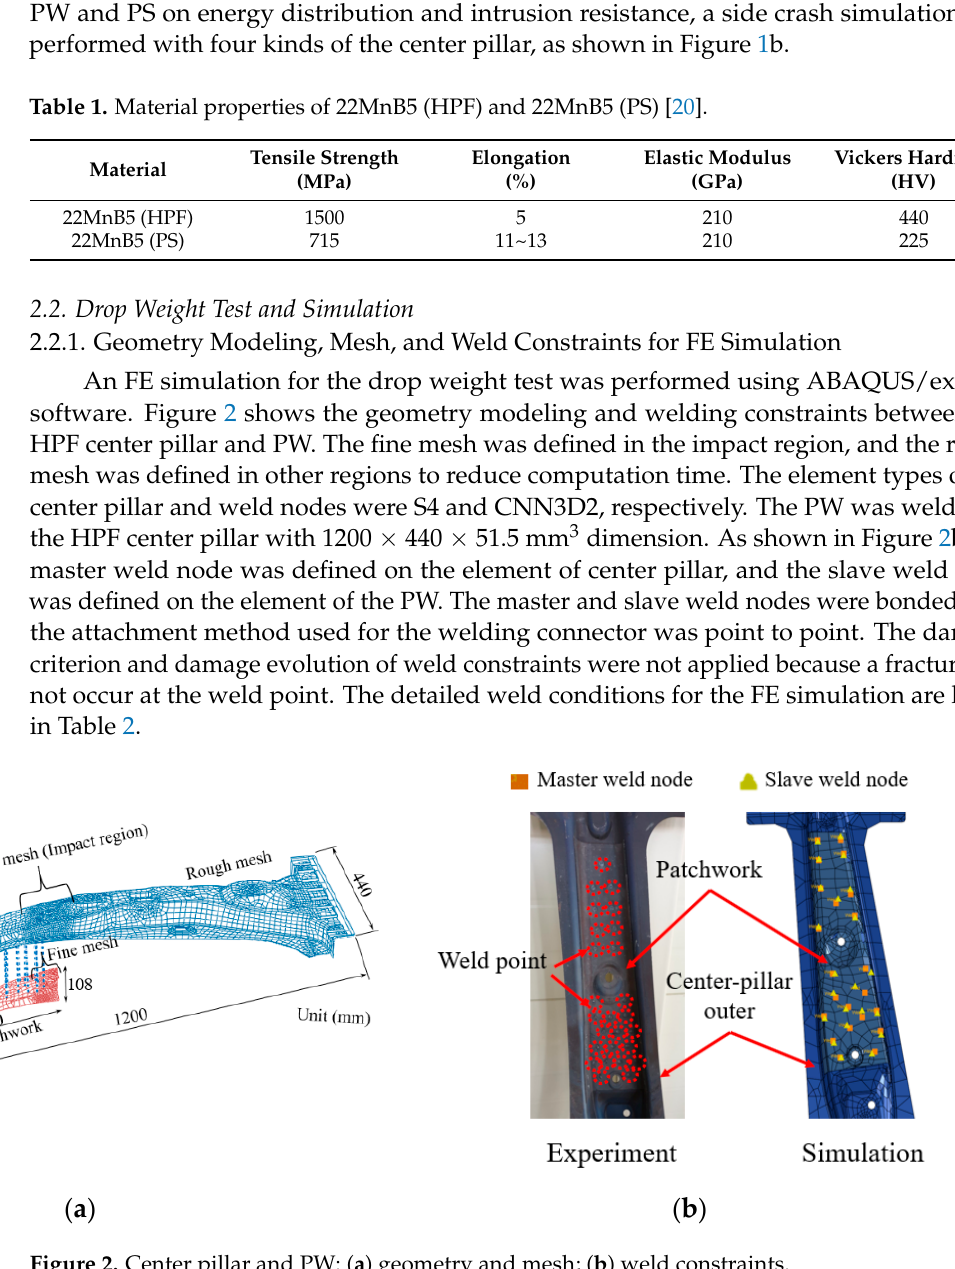
Figure 1. ( a ) Function of the center pillar during a side crash. ( b ) Four kinds center pillars [20].